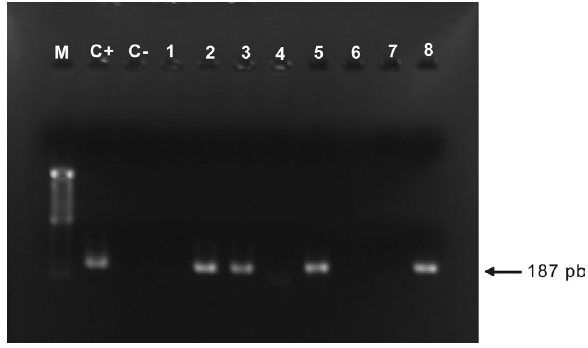
Figura 1. Gel de agarose 1% corado com brometo de etídio. Reação em cadeia de polimerase – nested RT-PCR – de amostras de ovócitos de cabras infectadas com o vírus da Artrite Encefalite Caprina, bandas de